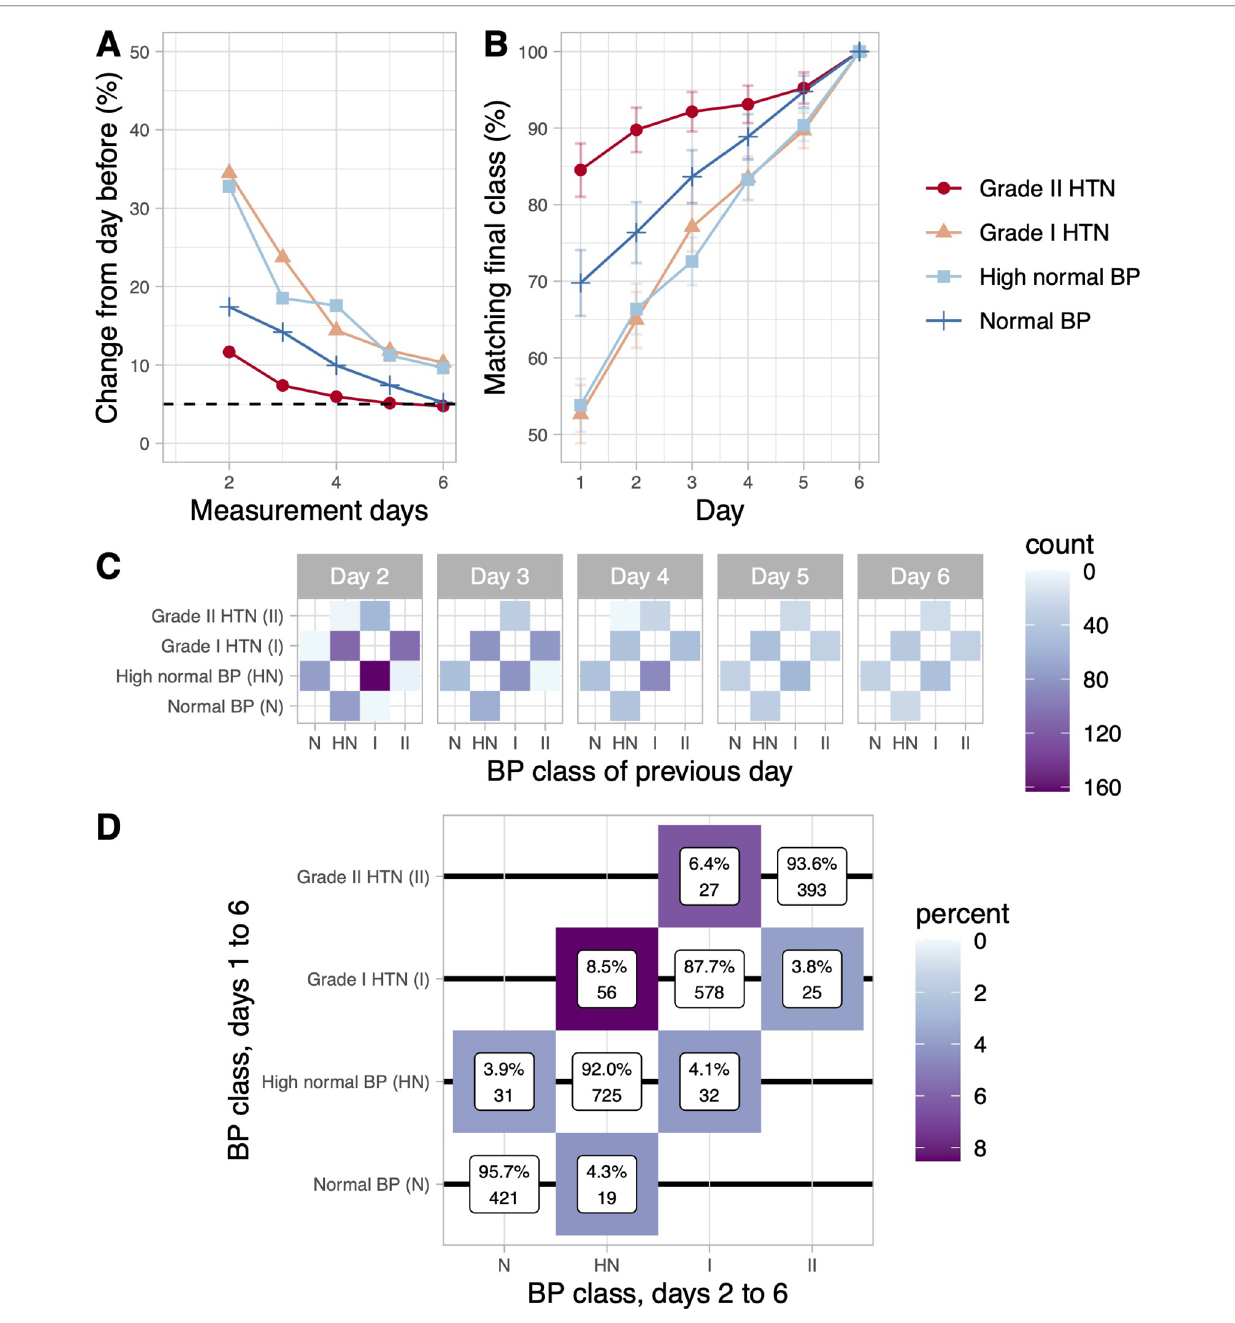
FIGURE 3 Blood pressure classi fi cation tracking during the HBPM protocol. ( A ) Fraction of users who were reclassi fi ed compared to the previous day; classi fi cation is always based on the cumulative BP mean of consecutive measurement days. ( B ) Percentage of users who already matched their fi nal BP-category. Classi fi cation is based on the cumulative BP-mean of day 1 – 6. ( C ) Number of patients who changed their classi fi cation compared to the classi fi cation from the previous day. ( D ) Change in blood pressure categories after exclusion of day 1. The crosstab shows how users (grouped by category based on day 1 – 6 mean, vertical) are classi fi ed according to a day 2 – 6 protocol. ( A – D ) Analyses are based on data obtained from users with self-reported hypertension who completed the fi rst HBPM -period ( n